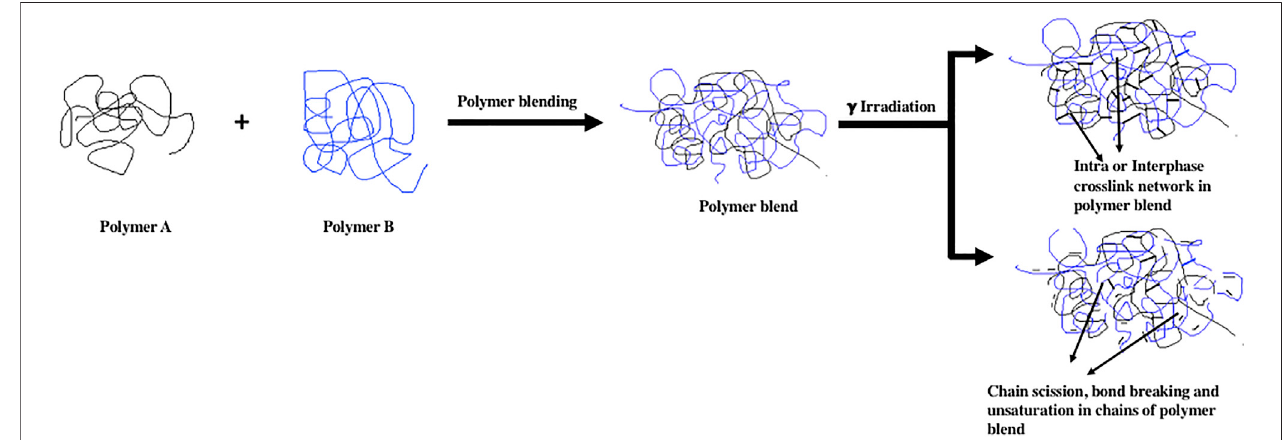
FIGURE 6 | Schematic diagram of the effect of gamma irradiation on chain scission and chain crosslinking in intra and intraphase in polymer blends.